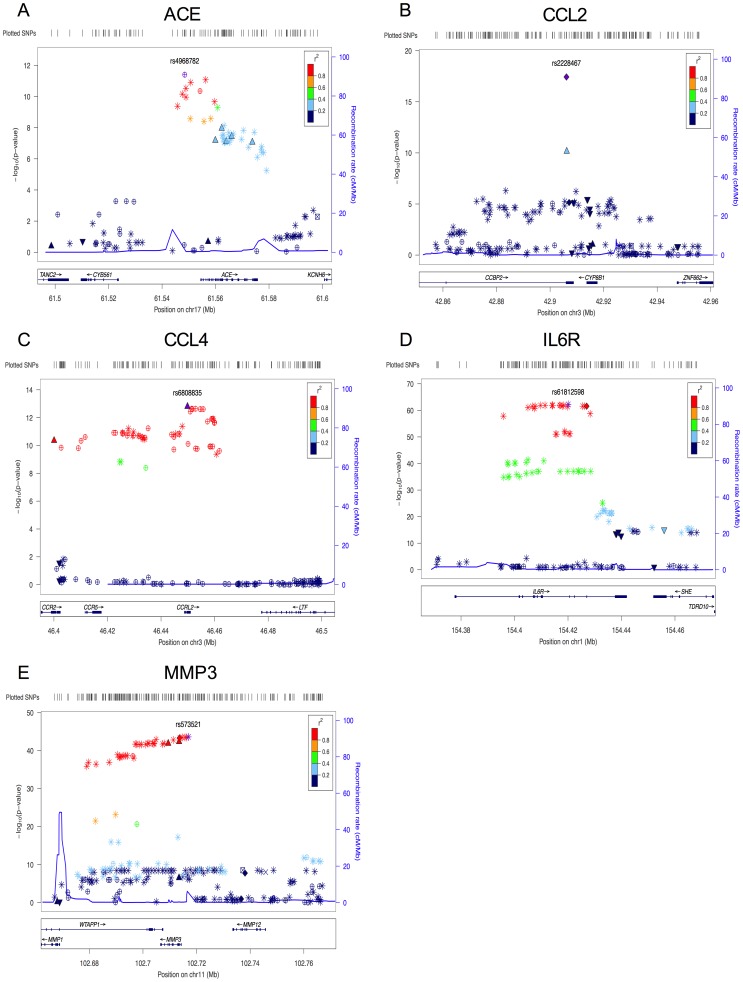
Plots for the region surrounding the genome-wide significant locus for each phenotype.A) region of rs4968782 (ACE), B) region of rs2228467 (CCL2), C) region of rs6808835 (CCL4), D) region of rs61812598 (IL6R), E) region of rs573521 (MMP3). The top SNP for each region is shown in purple. The correlations (r2) of each of the surrounding SNPs to the top SNP are shown in the indicated colors. Recombination rate is shown in blue. SNP annotation is as follows: circle = framestop, square-splice, diamond = nonsynonymous, triangle = coding, inverted triangle = UTR, X = conserved transcription factor binding, square with X = MCS44Placental, star = no annotation, circle with crosshairs = none.